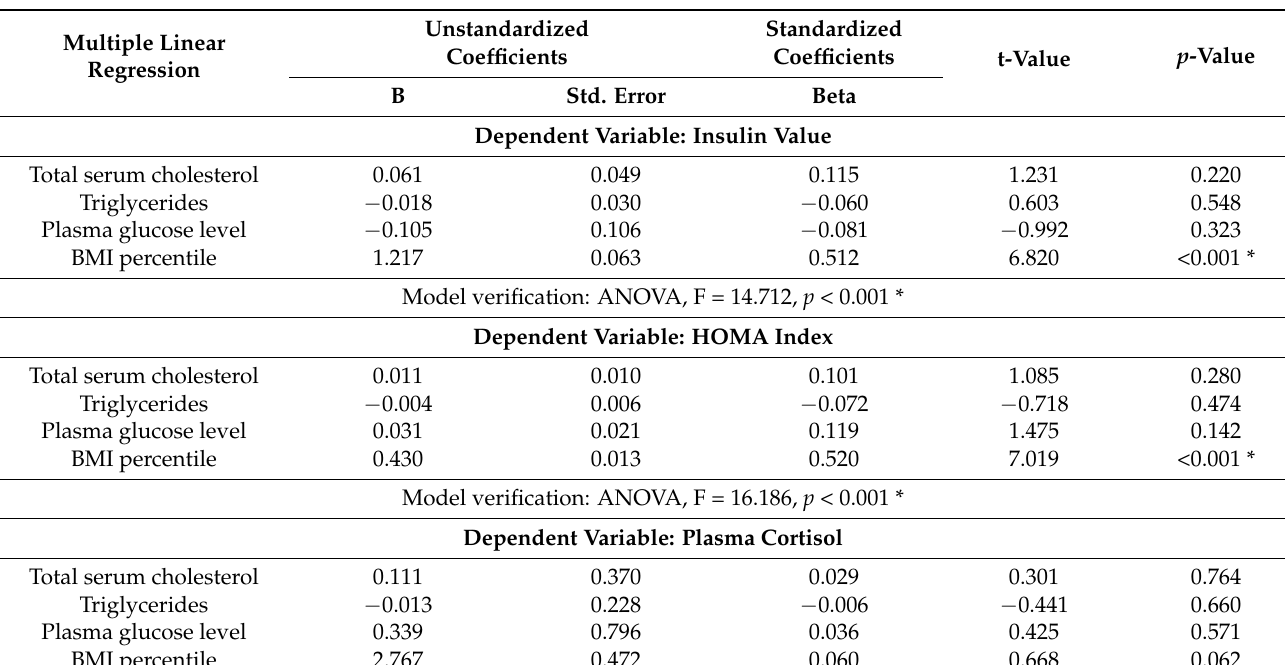
Table 5. The coefficients of multiple linear regression regarding the correlations between metabolic markers of insulin resistance and BMI percentile and biochemical